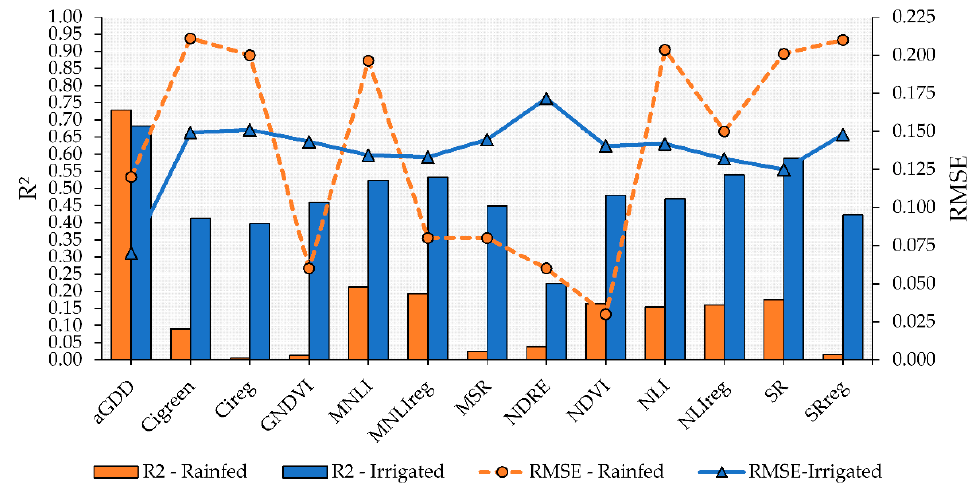
Figure 4. Performance of vegetation indices (VIs) to predict peanut pod maturity in irrigated and rainfed areas using linear regression. Blue bars and solid line with triangle symbol indicate the R 2 and RMSE, respectively, for the irrigated area. Orange bars and dashed orange line with circle symbol indicate the R 2 and RMSE, respectively, for the rainfed area.